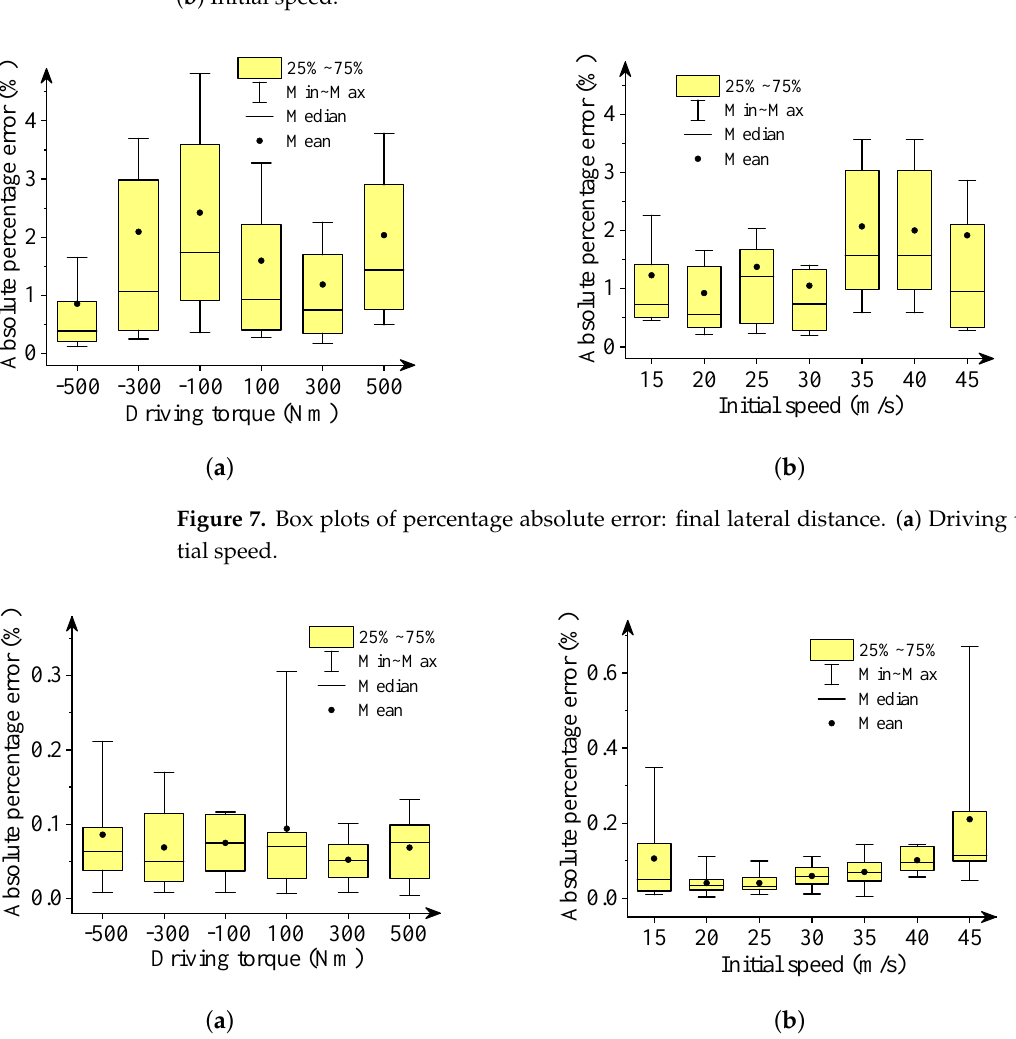
Figure 6. Box plots of absolute percentage error: final longitudinal distance. ( a ) Driving torque; ( b ) Initial speed.